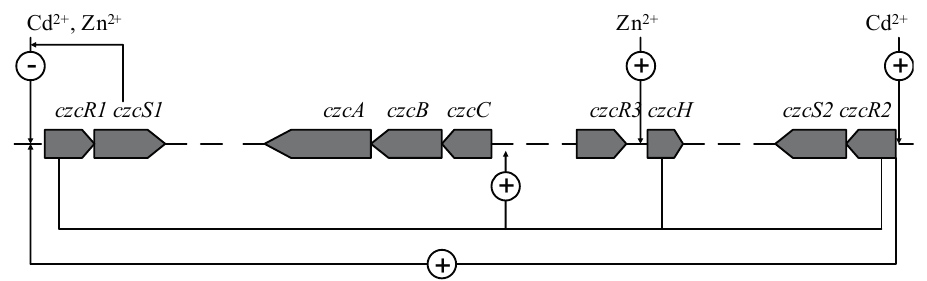
Figure 5. Model representing the cross-interaction among Zn 2+ , Cd 2+ , czcRS , and czcA . Based on the data from the LacZ fusion assay and qRT-PCR, the cross-talk among Zn 2+ , Cd 2+ , czcRS , and czcA was depicted. Zn 2+ and Cd 2+ repressed the transcription of czcRS1